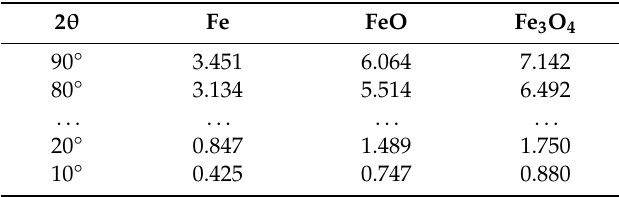
Table 3. Depth of X-ray detection of Fe and its oxides ( µ m).